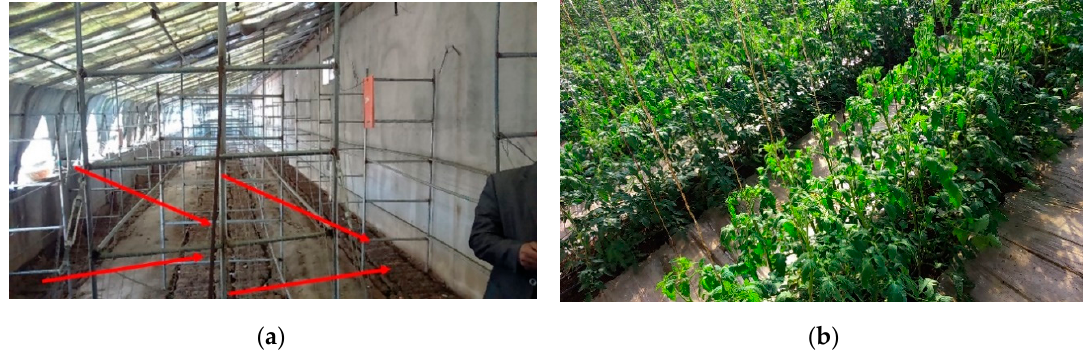
Figure 4. Spent mushroom substrate used as growing media in simple soilless culture systems (SCS) in Shandong province in China. ( a ) Spent mushroom substrate. Mushroom production is usually placed in the North part of the greenhouse. ( b ) Tomato production in simple SCS in the South part of the greenhouse. Here, the spent mushroom substrate is utilized as a growing medium (Photos: Gruda, private collection).